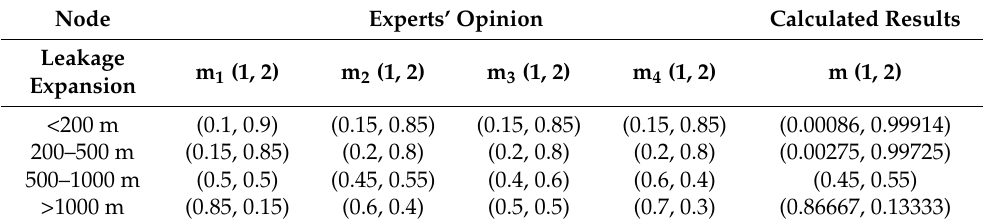
Table 2. Conditions probability of liquid ammonia leakage to